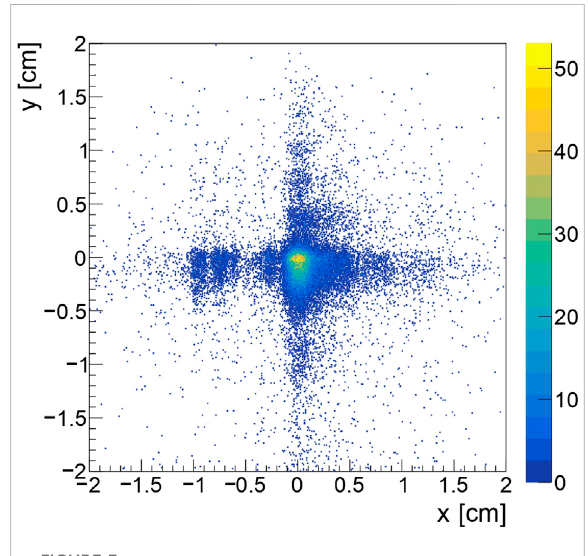
FIGURE 3 Beam pro fi le obtained from the projection on the target plane of the beam tracks reconstructed by the BM